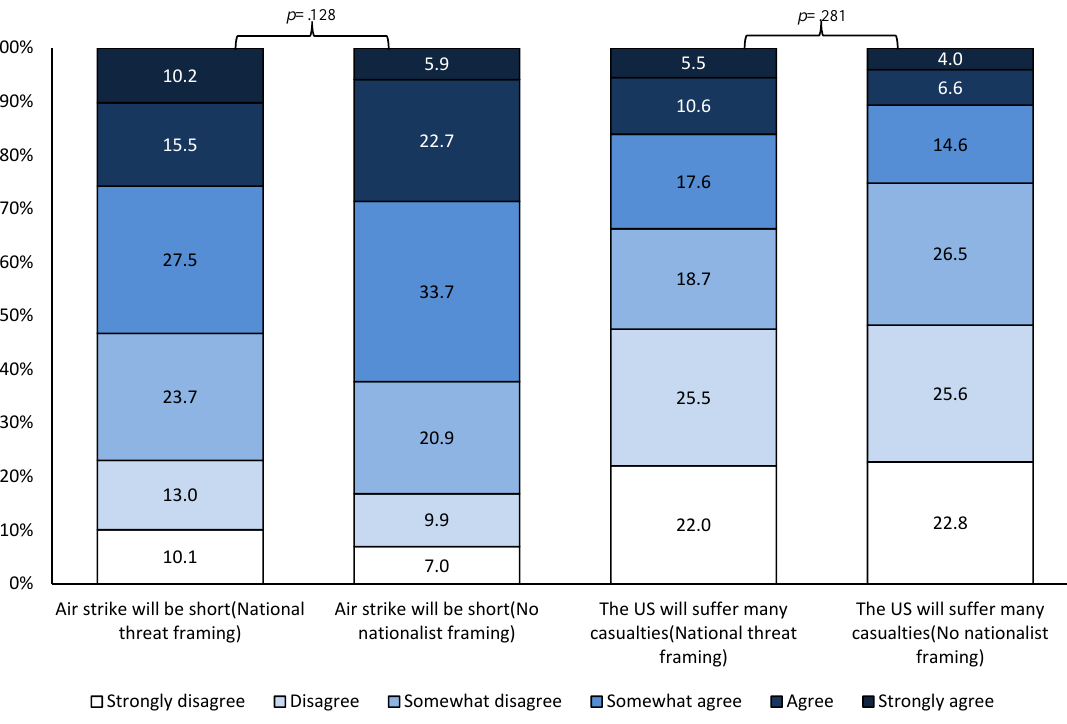
Figure 5: Effects of national threat framing on assessment of duration of air strike and number of U.S. casualties ( N = 558). p -Values are based on Wilcoxon–Mann–Whitney nonparametric test of differences between independent